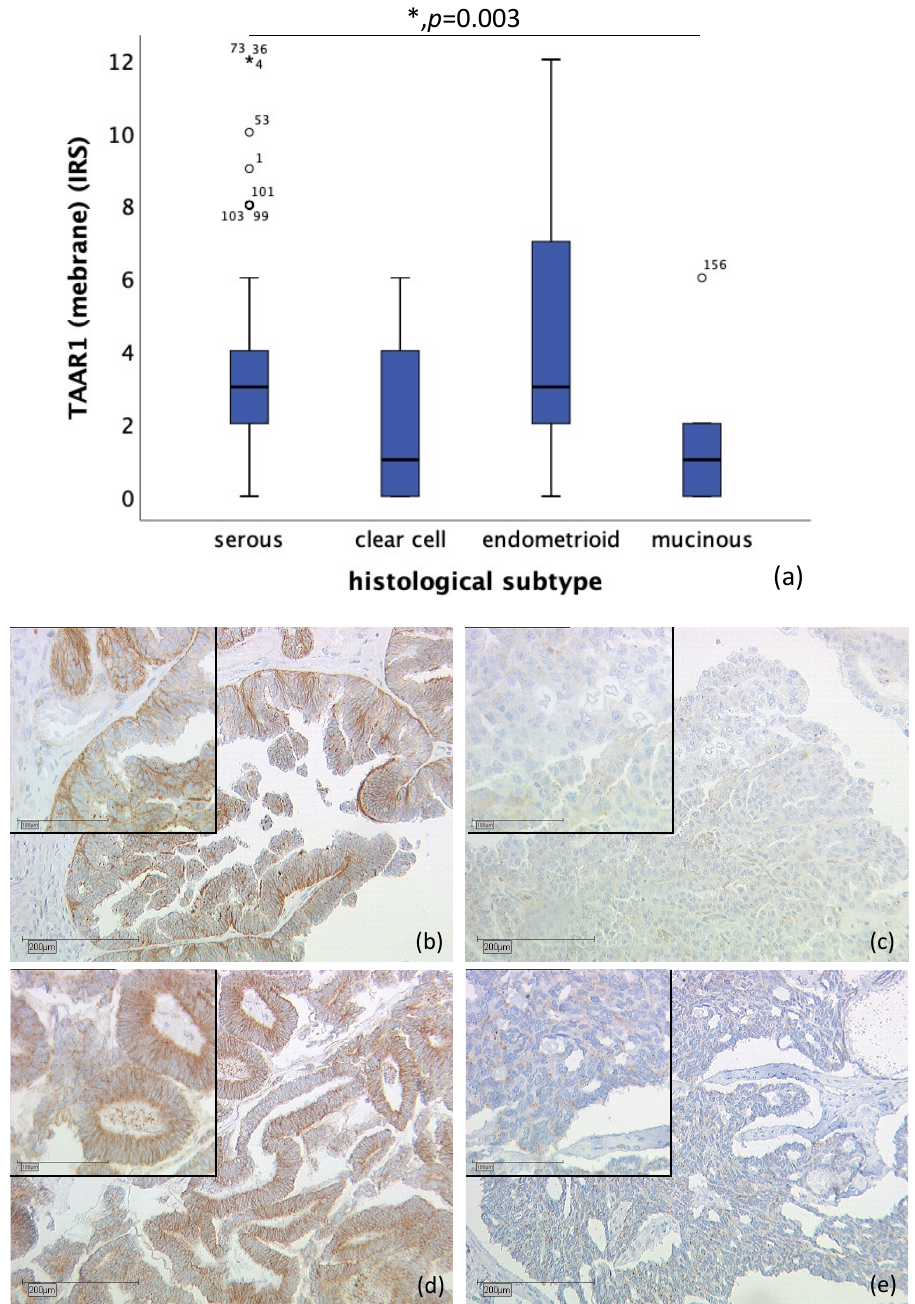
Figure 1. Correlation of membrane TAAR1 expression with histological subtype ( p = 0.003) ( a ) boxplot of membrane TAAR1 expression and histological subtype ( b ) serous carcinoma ( n = 98) with a membrane TAAR1 IRS of 4, magnification ×10 and ×25 in the inset ( c ) clear cell carcinoma ( n = 9) with a membrane TAAR1 IRS of 1, magnification ×10 and ×25 in the inset ( d ) endometrioid carcinoma ( n = 16) with a membrane TAAR1 IRS of 4, magnification ×10 and ×25 in the inset ( e ) mucinous carcinoma ( n = 11) with a membrane TAAR1 IRS of 0, magnification ×10 and ×25 in the inset; * p < 0.05 was considered statistically significant.